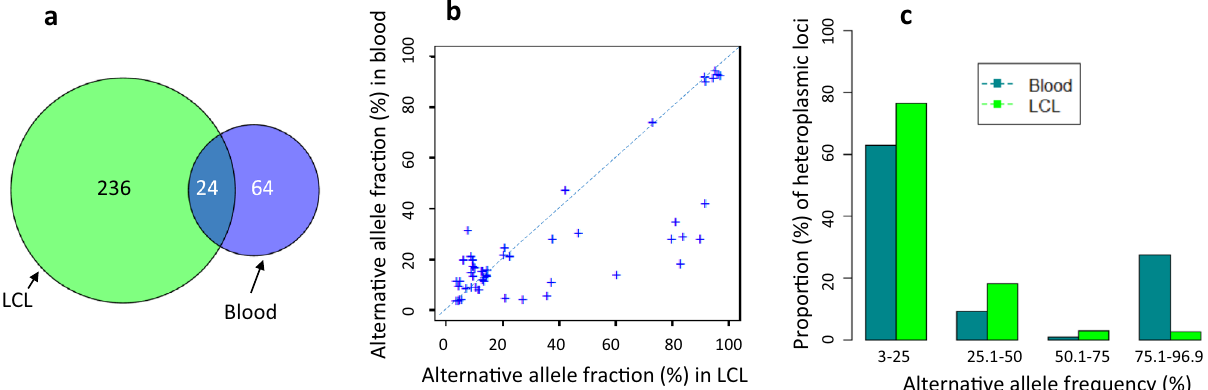
Figure 3. Comparison of heteroplasmic sites between 130 paired LCL and whole blood samples. ( a ) Venn diagram of the observed homoplasmic sites in LCL and whole blood samples. ( b ) Comparison of the AAFs (%) of 24 heteroplasmic sites that are present in both LCL and whole blood samples. ( c ) Comparison of the AAFs of 258 and 85 heteroplasmic sites between LCL and whole blood samples. AAFs, alternative allele fractions. LCL, lymphoblastoid cell